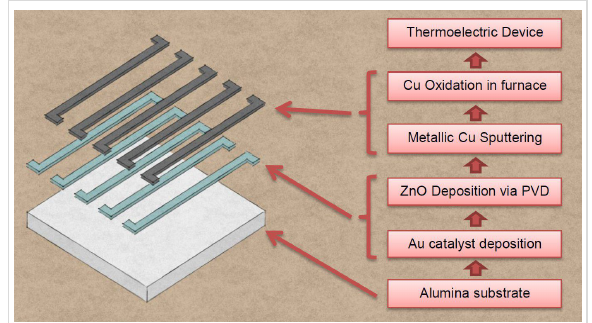
Figure 7: Schematics of the fabrication